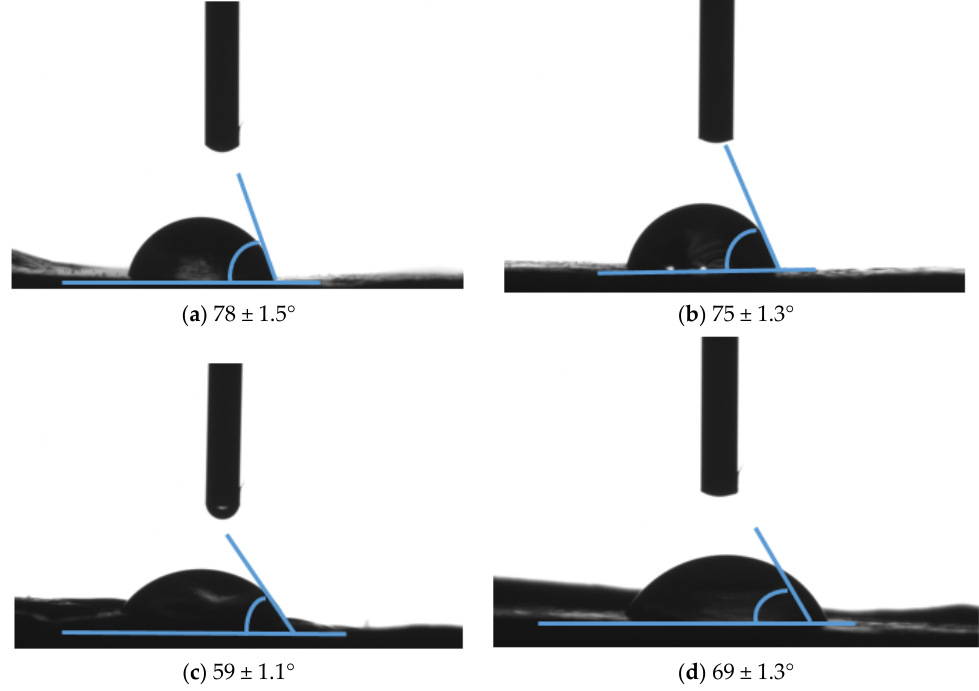
Figure 6. Contact angle measurements of ( a ) PVDF-HFP; ( b ) Ag/PVDF-HFP, ( c ) MWCNTs/PVDF- HFP and ( d )